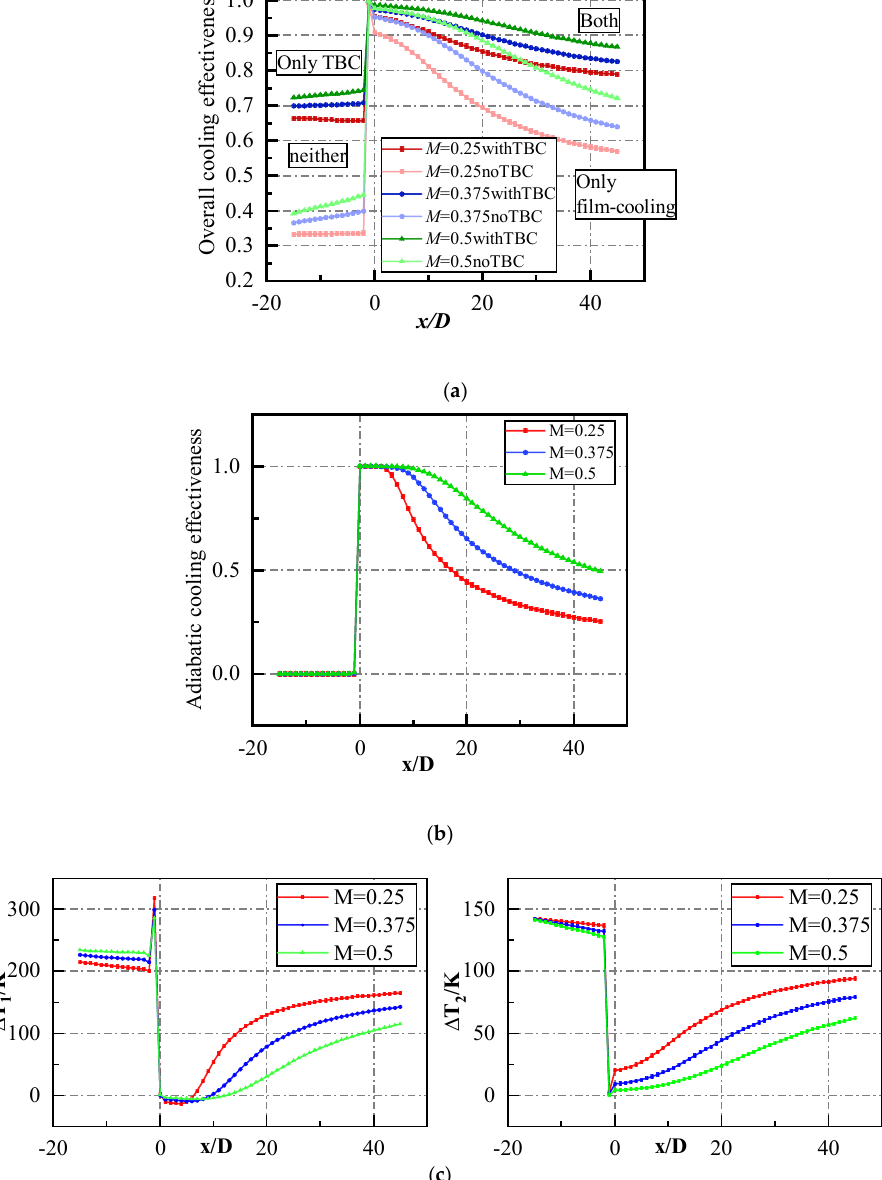
(cid:0) (cid:1) Figure 6. Results under h (cid:2870) (cid:3404) 15000 W/ (cid:4666) m (cid:2870) ∙ K (cid:4667) and 𝛾 (cid:3404) 9 ; ( a ) distribution of 𝜂 with or without Figure 6. Results under h 2 = 15,000 W/ m 2 · K and γ = 9; ( a ) distribution of η with or without TBC (cid:0) (cid:1) at different BR under h 2 = 15,000 W/ m 2 · K and γ = 9; ( b ) distribution of η t at different BR under (cid:0) (cid:1) h 2 = 15,000 W/ m 2 · K and γ = 9; ( c ) distribution of ∆ T 1 and ∆ T 2 under h 2 = 15,000 W/ and γ =